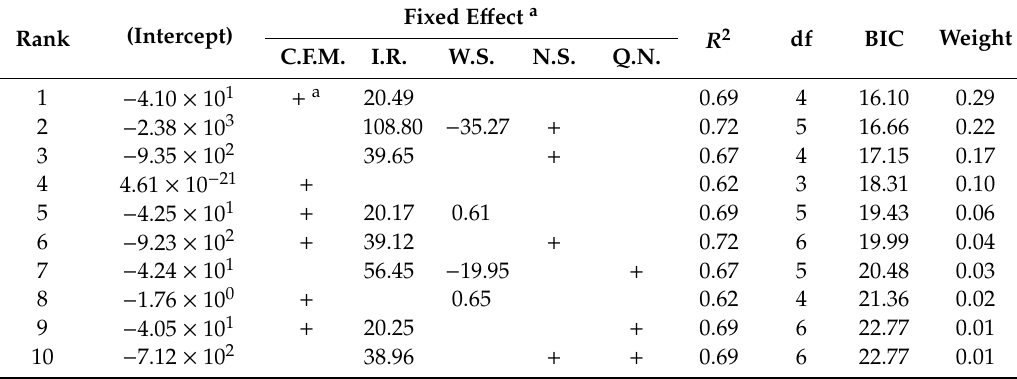
Table 4. The top ten models set with corresponding BIC values and rounded model weights used to assess the e ff ect of life-history traits and number of interception records on the establishment risks of ant